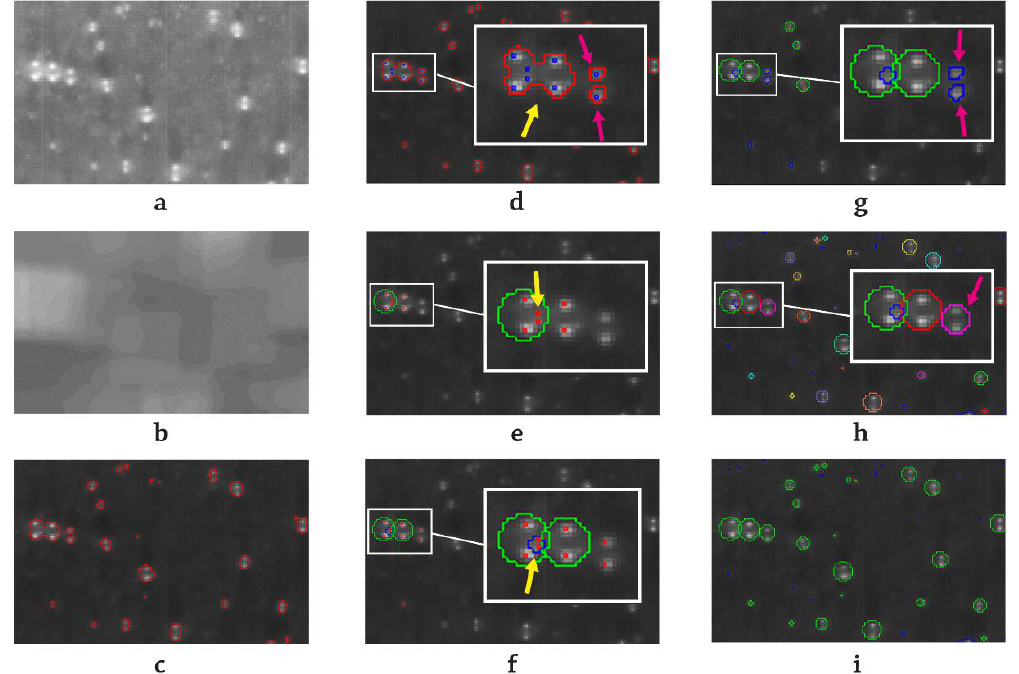
Figure 4. Illustrative image sequence for the front projection optical recognition T b = 85 °C, p = 150 kPa, G = 484 kg/s·m 2 , q w = 500kW/m 2 . ( a ) Original image; ( b ) reference image (smoothed); ( c ) bubble